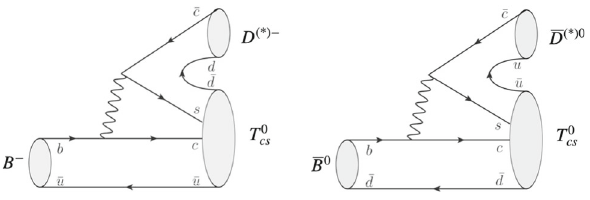
Fig. 4 Topological diagrams of B mesons decaying into T 0 cs